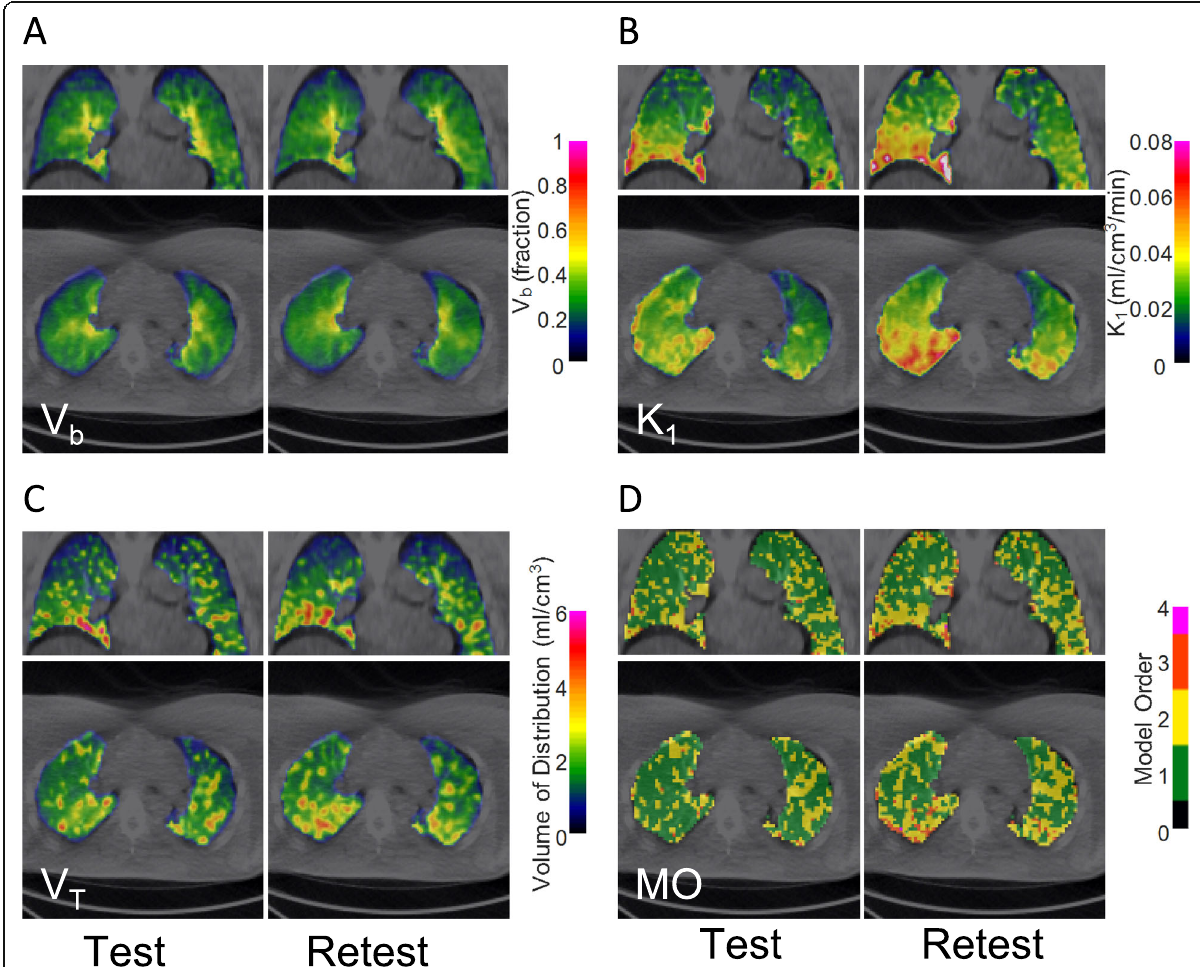
Fig. 5 Representative parametric lung images obtained from DEPICT analysis of [ 11 C]VC-002 binding in subject #1. Note that the heart and liver were not included in the generation of parametric images. a Fractional blood volume ( V b ). b Kinetic rate constant K 1 , showing the radioligand influx rate from blood to tissue that is proportional to blood flow and the radioligand extraction coefficient. c Total distribution volume ( V T ), which is the main outcome parameter of the analysis. d Compartmental model order (MO), showing the estimated number of pharmacokinetic compartments in tissue that is sufficient to adequately describe the